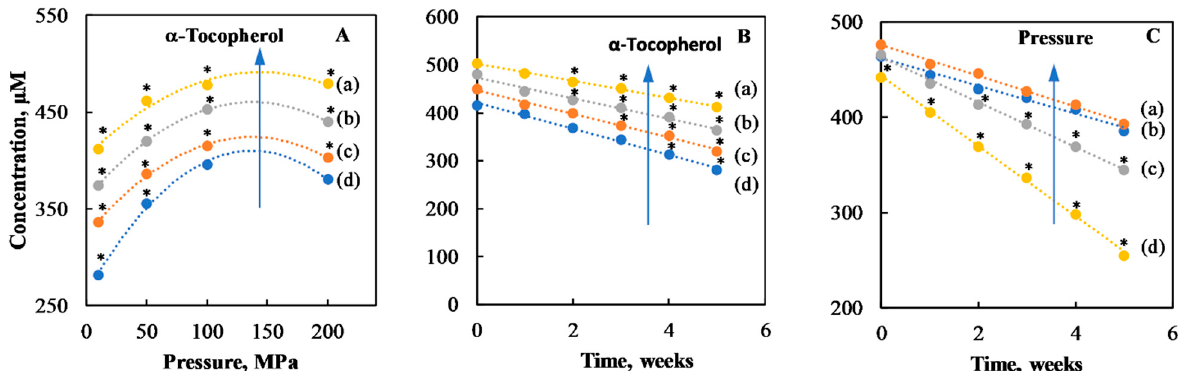
Figure 6. Average concentration of vitamin A showing the interaction of factors on its retention during shelf-life storage: ( A ), pressure (from 10 to 200 MPa) and α -tocopherol (from 0 to 1 mg/g); ( B ), α -tocopherol (from 0 to 1 mg/g) and time (from 0 to 5 weeks); ( C ), pressure (from 10 to 200 MPa) and time (from 0 to 5 weeks): ( a ); 0 mg/g; ( b ) 0.25 mg/g; ( c ) 0.50 mg/g; ( d ) 1.00 mg/g. Points marked with (*) are significantly different (Tukey HSD, p < 0.05).